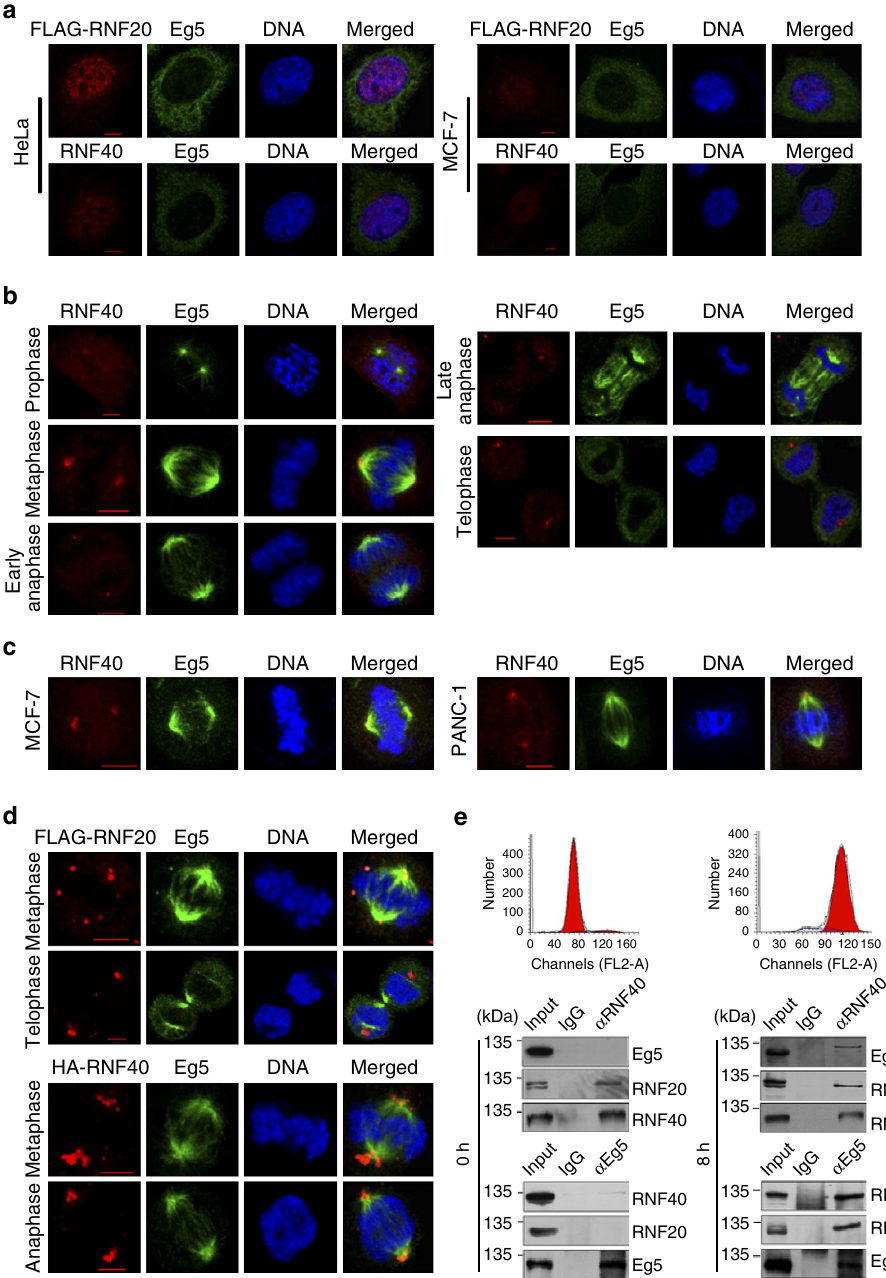
Figure 2 | The RNF20/40 complex is co-localized with Eg5 at spindle poles during mitosis. ( a ) Subcellular localization of Eg5, RNF40, and FLAG-RNF20 in interphase HeLa and MCF-7 cells. The distribution of endogenous Eg5 and RNF40 or exogenous FLAG-RNF20 was detected by immunofluorescence assays using anti-RNF40, or anti-FLAG together with anti-Eg5. DAPI staining was conducted to visualize the cell nuclei. Scale bar, 5 m m. ( b ) Co-localization of endogenous RNF40 with Eg5 during different phases of mitosis in HeLa cells. The distribution of endogenous Eg5 and RNF40 was detected using immunofluorescence assays with anti-Eg5 and anti-RNF40. Scale bar, 5 m m. ( c ) Co-localization of endogenous RNF40 with Eg5 at spindle poles during mitosis in MCF-7 and PANC-1 cells. Scale bar, 5 m m. ( d ) Co-localization of overexpressed HA-RNF40 and FLAG-RNF20 with endogenous Eg5 at spindle poles during mitosis. HeLa cells were transfected with HA-RNF40 and FLAG-RNF20 expressing constructs. The localization of Eg5 and overexpressed HA-RNF40 or FLAG-RNF20 was detected by immunofluorescence assays using anti-HA or anti-FLAG together with anti-Eg5. Scale bar, 5 m m. ( e ) Interaction between Eg5 and RNF20/40 during mitosis. HeLa cells were synchronized in G 1 /S phase using double thymidine blocking and collected at 0 and 8h after release. Immunoprecipitation assays were performed with antibodies against the indicated proteins followed by